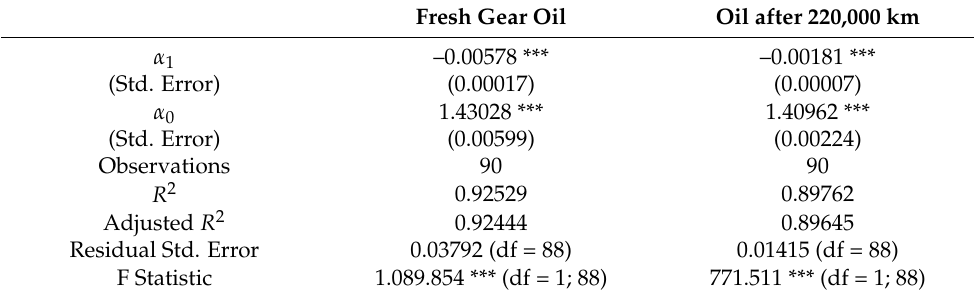
Table 4. Basic parameters of the linear regression model for oil SAE 80W-140.